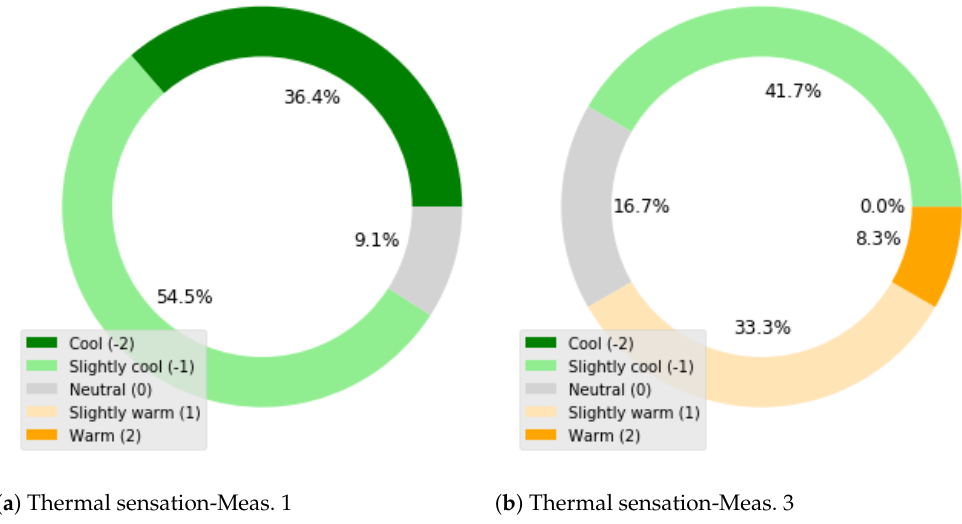
Figure 11. Results of the passengers survey. ( a , b ) show the thermal sensation of all the test subjects for Meas. 1 and Meas. 3,